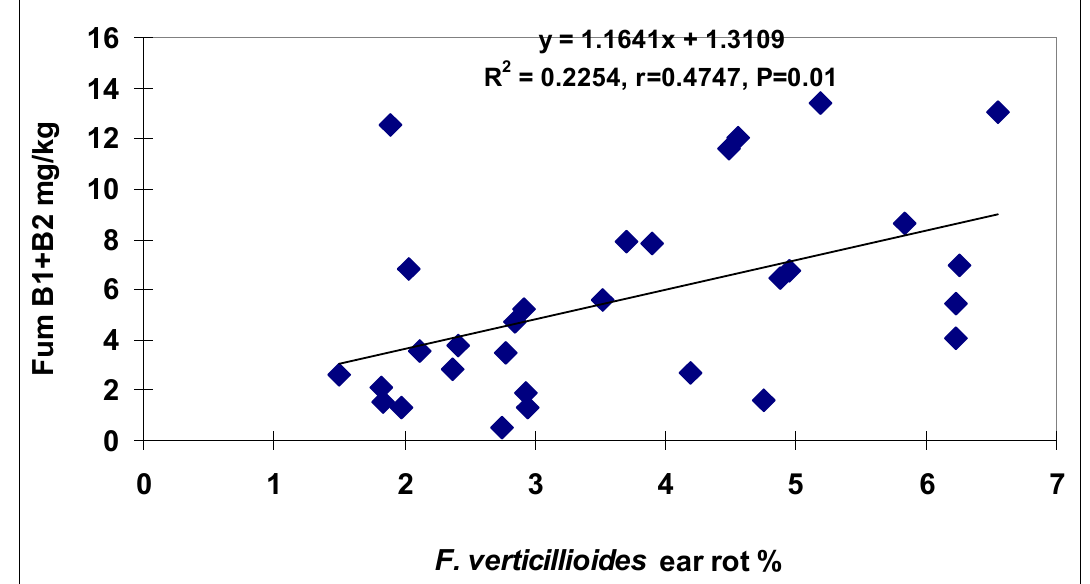
Figure 10. Regression between Fusarium verticillioides ear rot and fumonisin contamination ( n = 34), combined from toothpick and natural infection without the data of the three hybrids with toxin overproduction, Szeged, 2010–2011. LSD 5% = 9.44. Regression model from Excel built-in function.